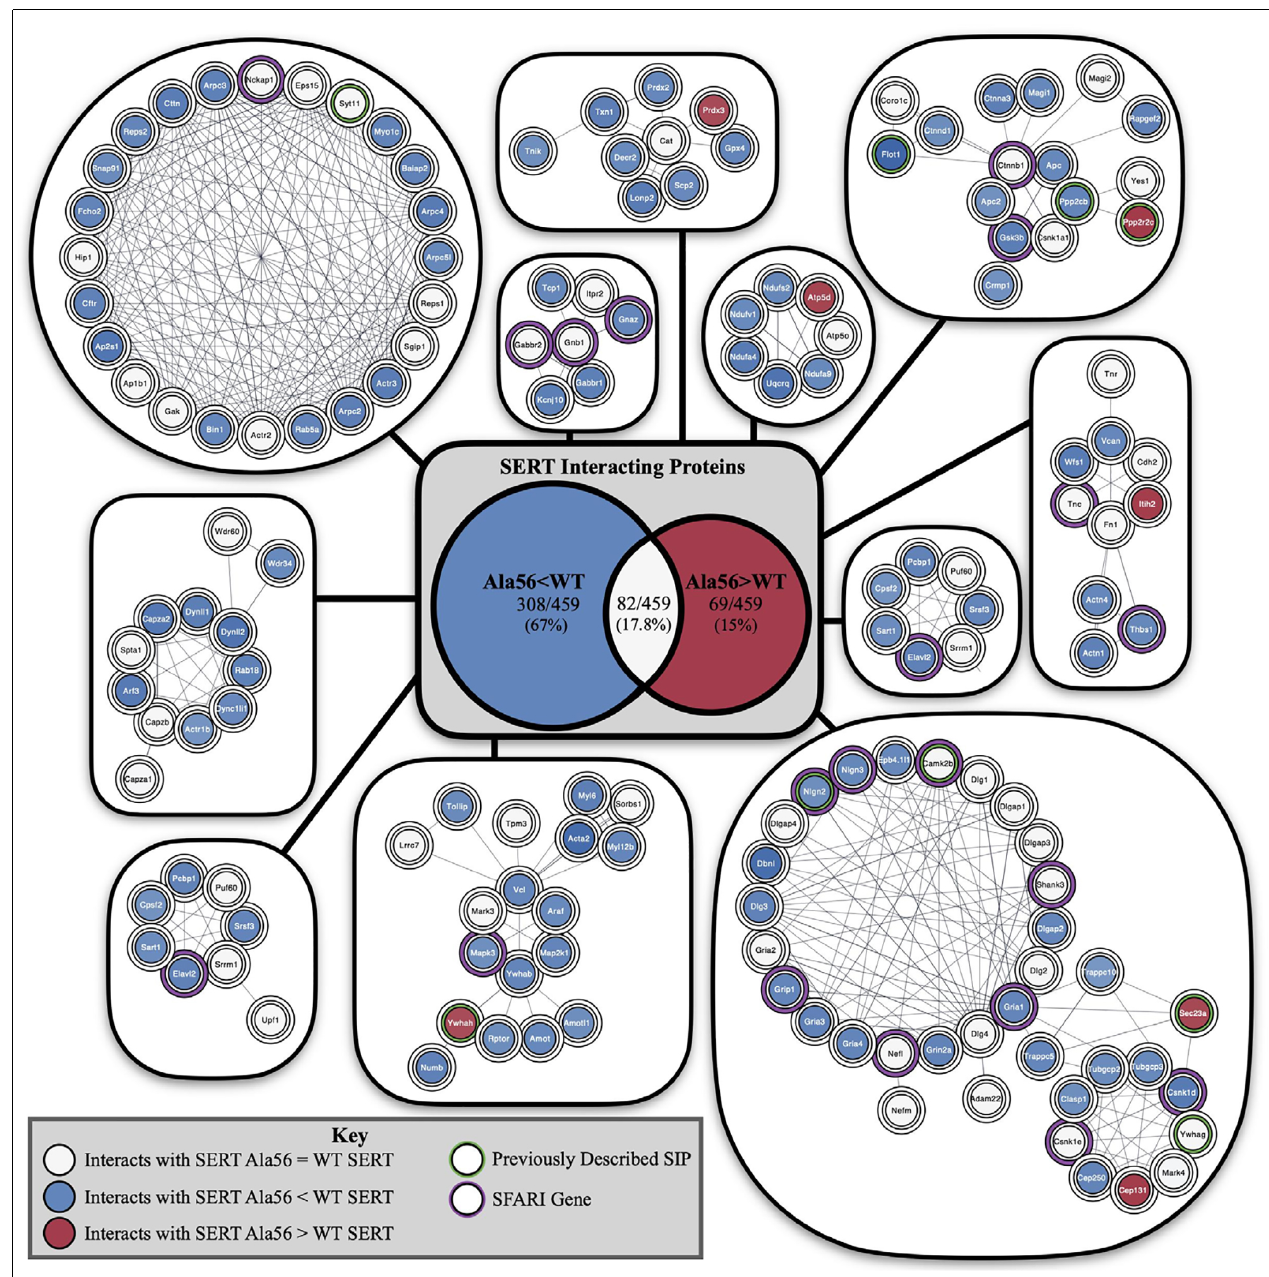
FIGURE 5 | Impact of the Ala56 coding variant on the abundance of SERT-interacting proteins as revealed by a proteomic analysis of midbrain extracts from SERT Ala56 mice. Highlighted proteins previously identified to interact with SERT with a green outline and identified SFARI genes with a purple outline. Center shows Venn diagram of proteins with decreased interactions with SERT Ala56 compared to WT SERT (blue), the number of proteins with increased interactions with SERT Ala56 compared to WT SERT (red) and the number of proteins with similar interaction with both SERT Ala56 and WT SERT (light gray). Figure derived from Quinlan et al.